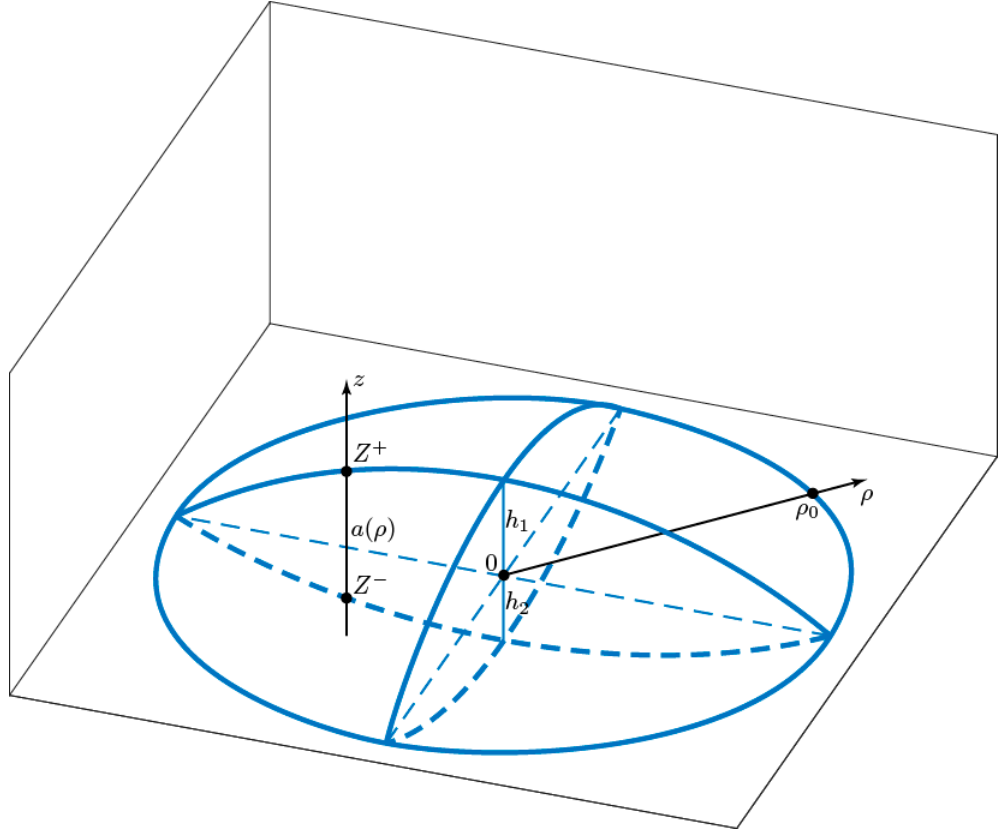
Figure 1. Schematics of the asymmetric biconvex quantum lens under consideration.